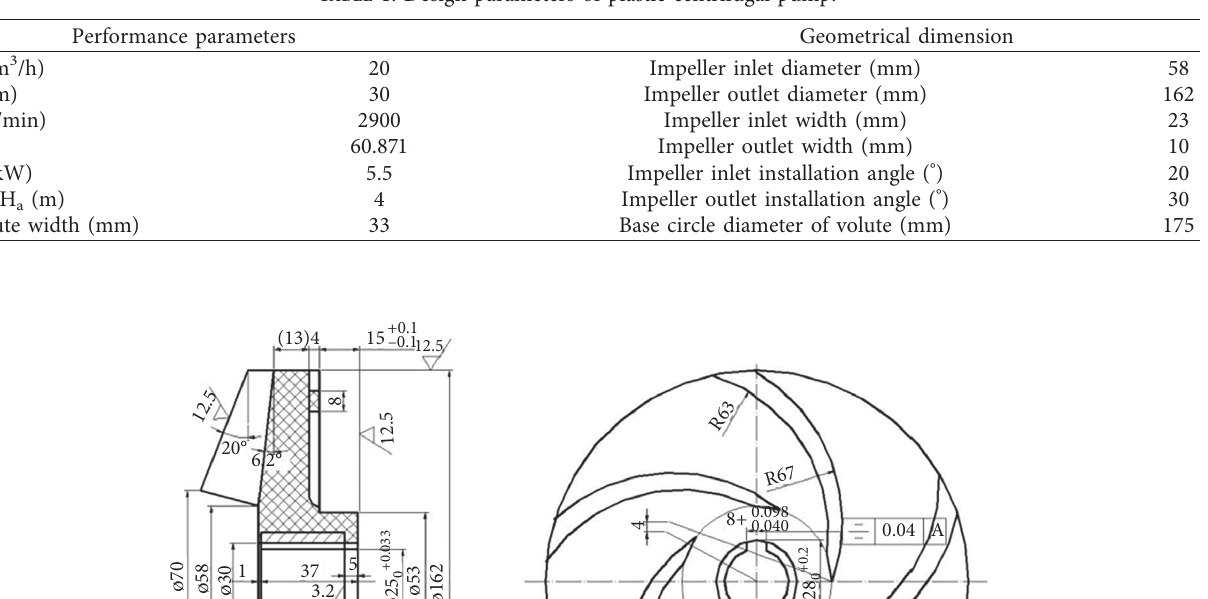
Figure 5: Blade profile of B-spline curve Table 1: Design parameters of plastic centrifugal pump.